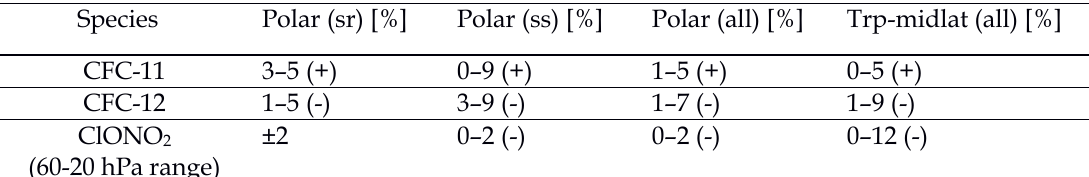
Table 2: Range of the bias (considered as percentage median of the differences in a statistically meaningful pressure range) between MIPAS2D and